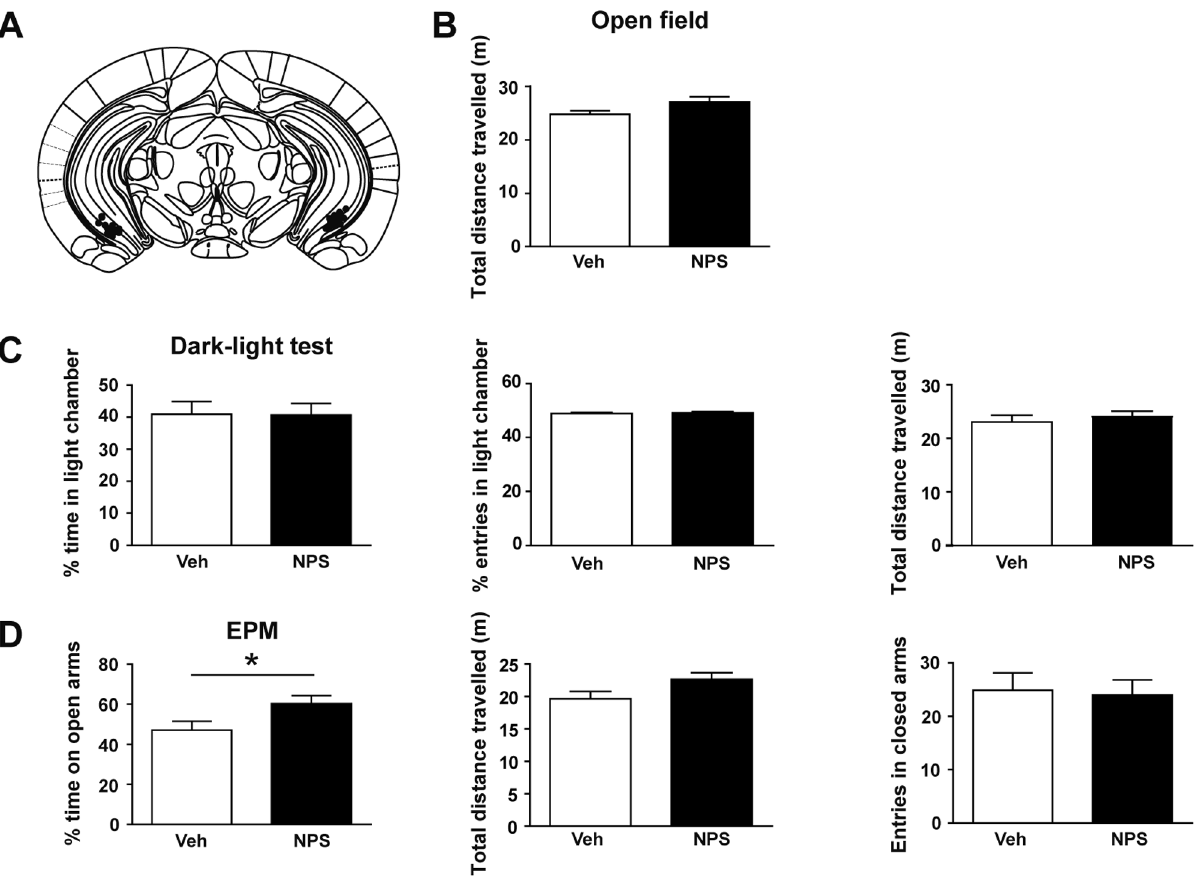
Figure 3. Microinjections of NPS into the VH reduce anxiety-like behavior in C57BL6/N mice. A, Anatomical plate showing the injection sites (n=8 mice per group). B, The distance travelled in the open field was not changed by NPS injection (p=0.074, t=1.928, df=14). C, Anxiety- and locomotion-related behavior in the dark-light test was not altered by NPS injection (parameters for anxiety-like behavior: % time in light chamber p=0.964, t=0.046, df=14 and % entries in light chamber p=0.553, t=0.608, df=14; parameter for locomotion: total distance travelled p=0.54, t=0.63, df=14). D, NPS injections decreased anxiety-related behavior on the EPM (parameter for anxiety-like behavior: % time on open arms p=0.042, t=2.227, df=14) without affecting locomotion (parameters for locomotion: total distance travelled p=0.073, t=1.94, df=14 and entries in closed arms p=0.842, t=0.203, df=14).